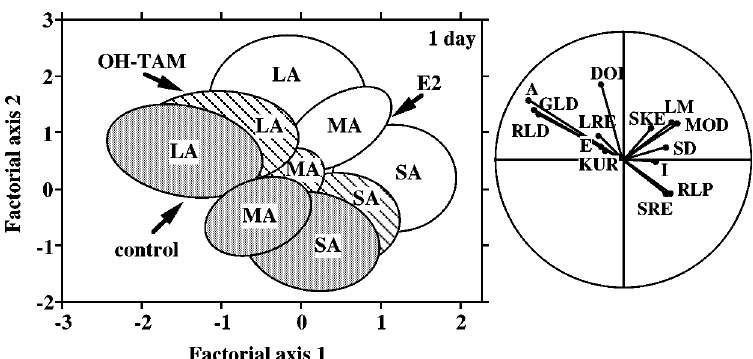
Fig. 9. Scattergram of the treated and untreated cells in the factorial principal plane determined by the multifactorial discriminant analysis on the Feulgen-stained nuclei. Each axis is a linear combination of the 14 axes related to the 14 parameters computed for each nucleus. Nine groups were considered, the three area subpopulations (SA, MA and LA) for control, E2 and OH-TAM treatments. Left hand: ellipses delineate the 95% tolerance region around the center of gravity of each group. Right hand: projections of the 14